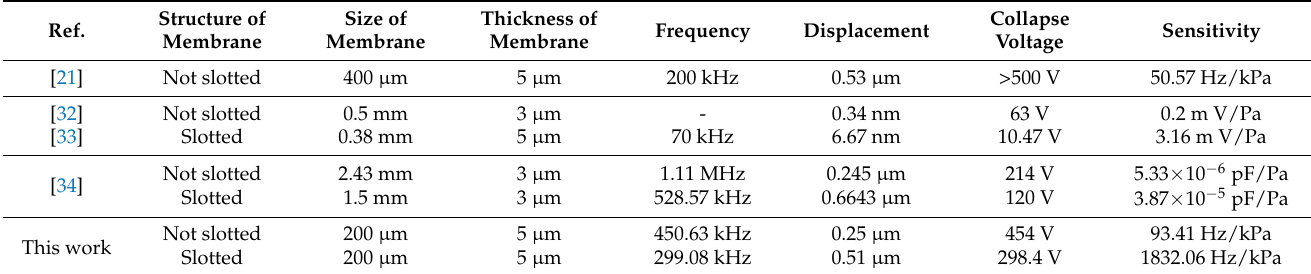
Table 8. Comparison between this work and other